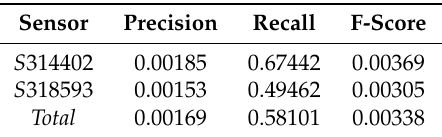
Table 15. The quality of fit for the Phase 2-Train data based on the thresholds determined by the labeled incidents.